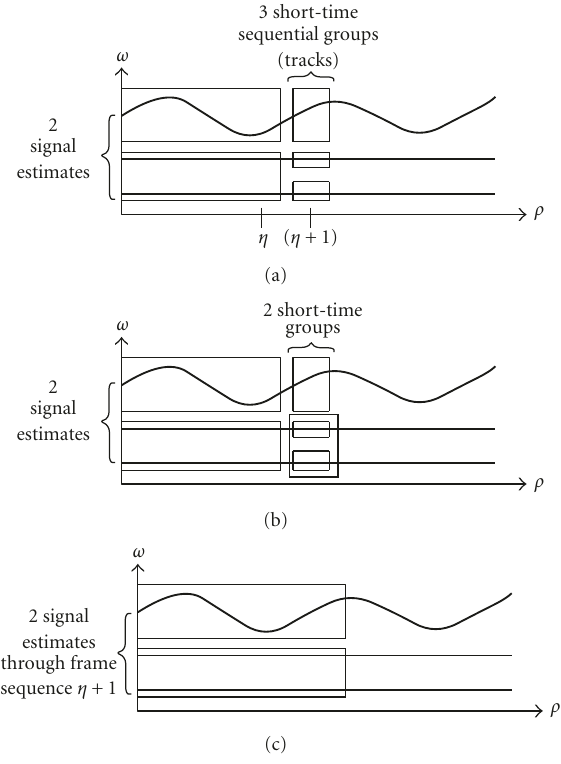
Figure 5: Illustration of short-time sequential-first grouping. Here the input signal is a mixture of the two single-source signals shown in Figure 2. (a) The graph shows short-time tracks in time segment ( η +1) with completed signal estimate groups through time segment η . Here, time segment η consists of time frames ρ ∈ { ηT (cid:5) , ... ,( η + 1) T (cid:5) − 1 } , and T (cid:5) = 6 . (b) The graph shows simultaneous groups of the short-time tracks shown in (a). (c) The graph shows completed signal estimate groups through time segment ( η +